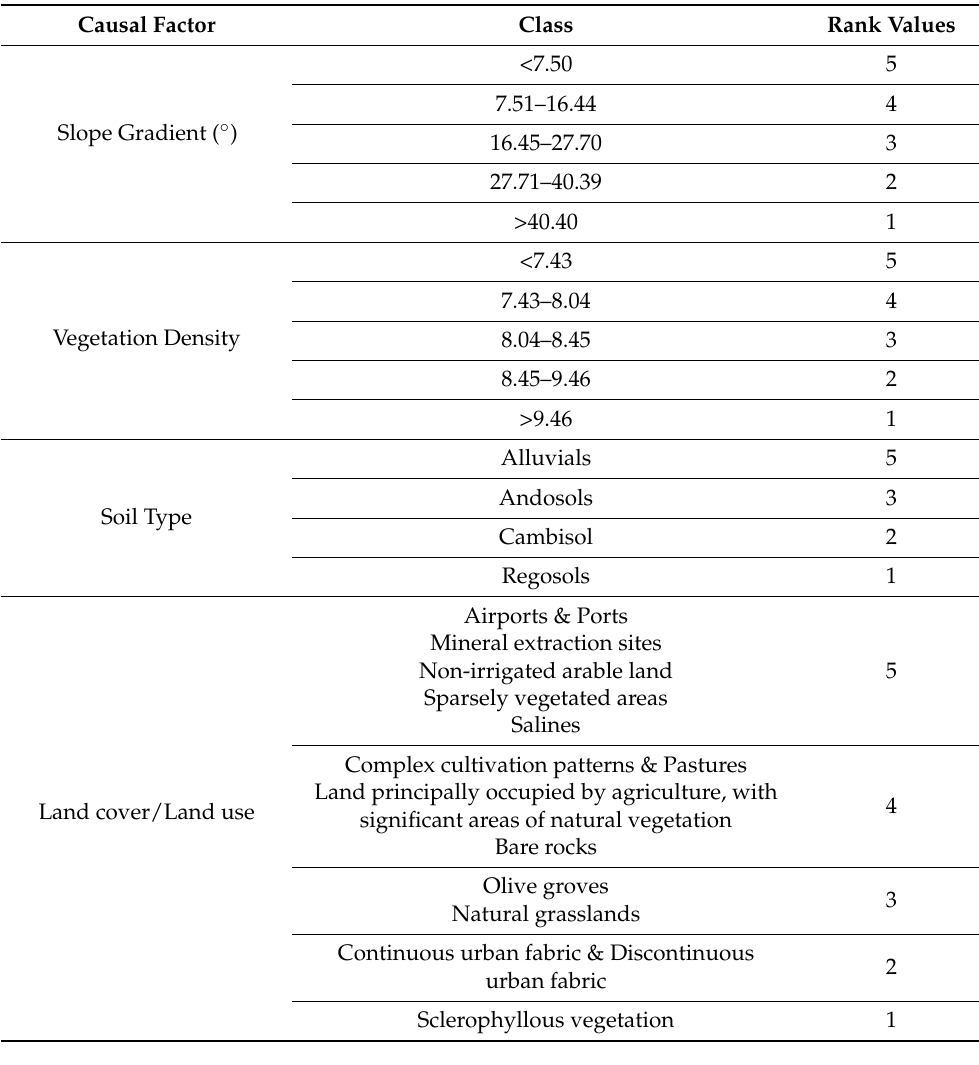
Table 3. Torrential flood causal factor classification and ranks in Milos and Thira